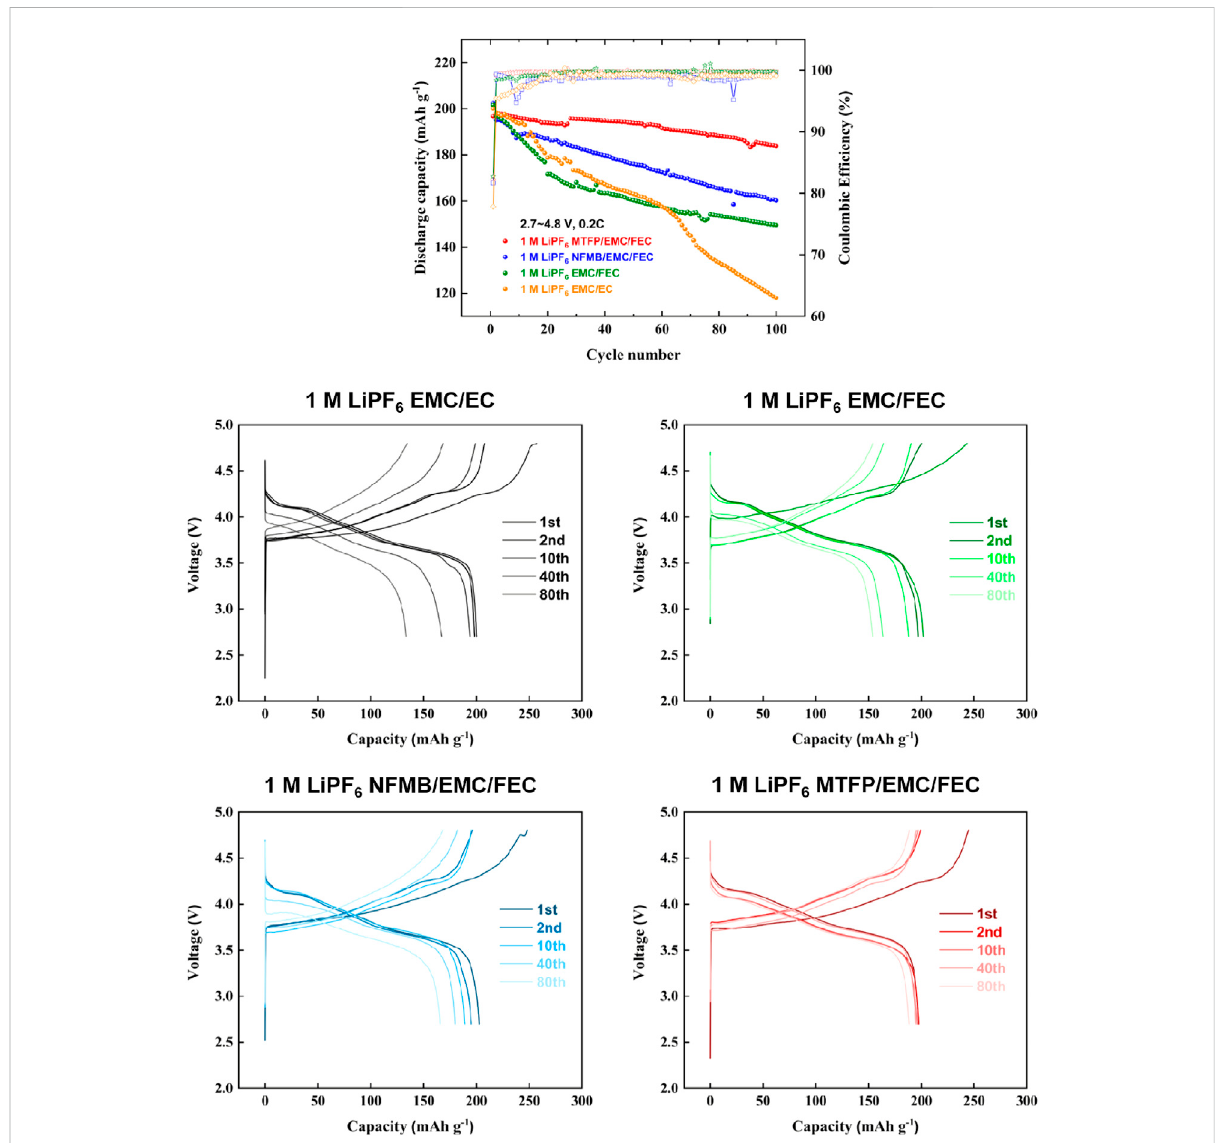
FIGURE 6 Charge-discharge cycling performances of Li/NCM811 coin-cells assembled with different electrolytes at a cut-off voltage of 2.7 – 4.8 V and a current density of 0.2 C.